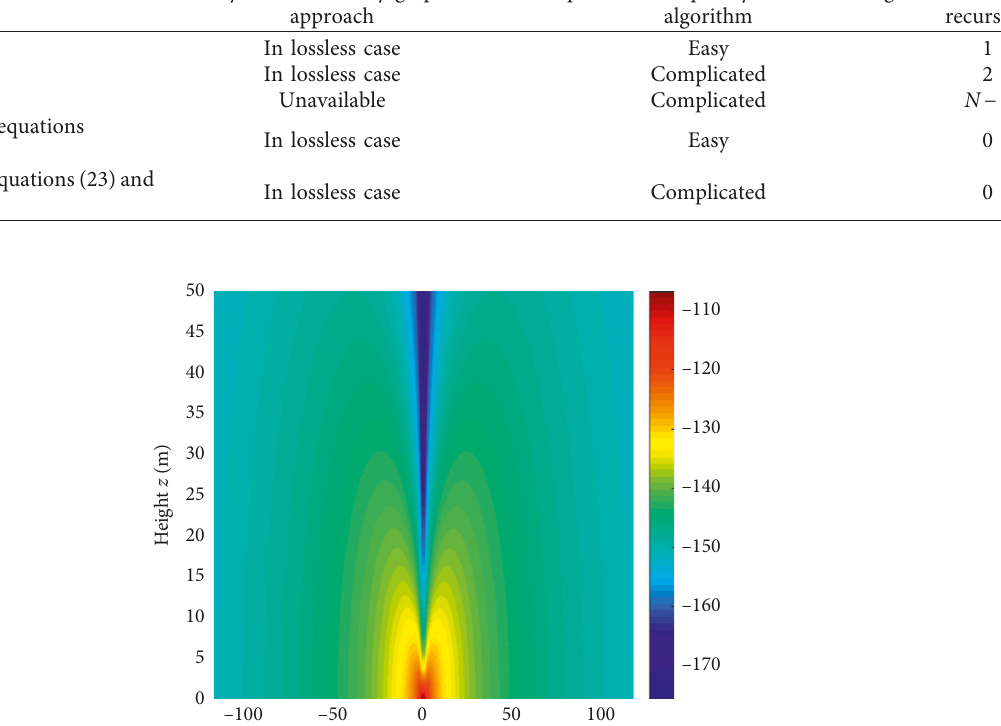
Table 1: Comparison of computational feasibility and complexity for root finding algorithms. ( n : represents the order of computations). Method